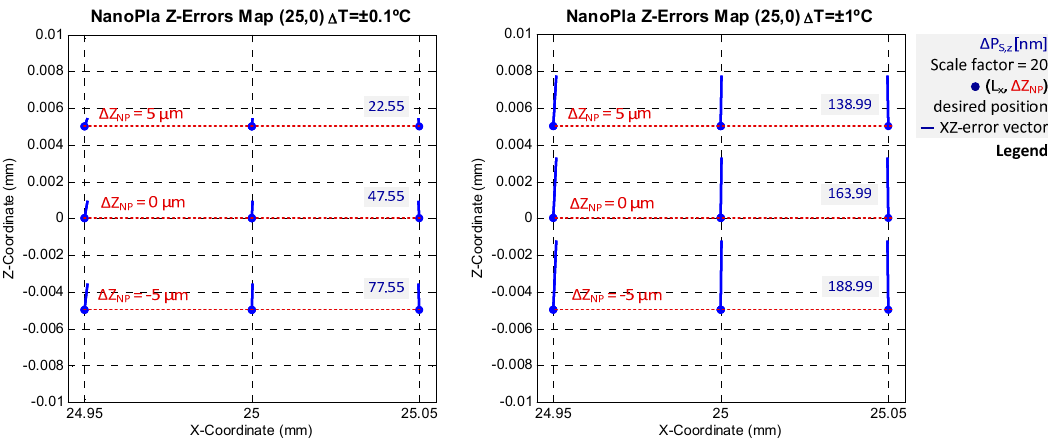
Figure 11. XZ-error mapping results (error values in mm) at the (25,0) position, considering different environmental conditions: ( Left ) ∆ T = ±0.1 °C; ( Right ) ∆ T = ±1 °C.